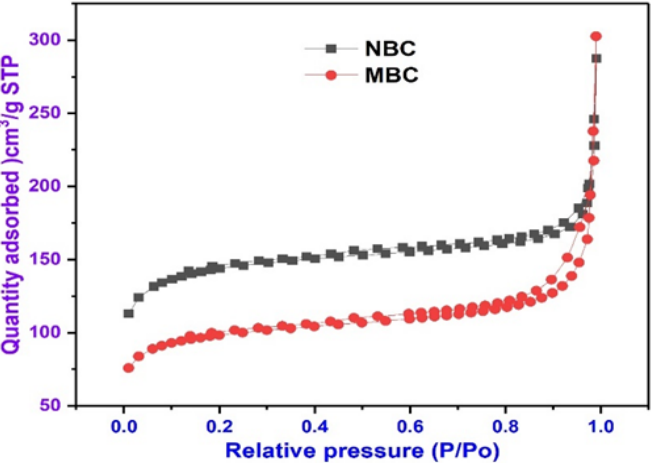
Figure 3. Nitrogen adsorption – desorption isotherm. Table 3. Physico-chemical properties of neat biochar and magnetic biochar.